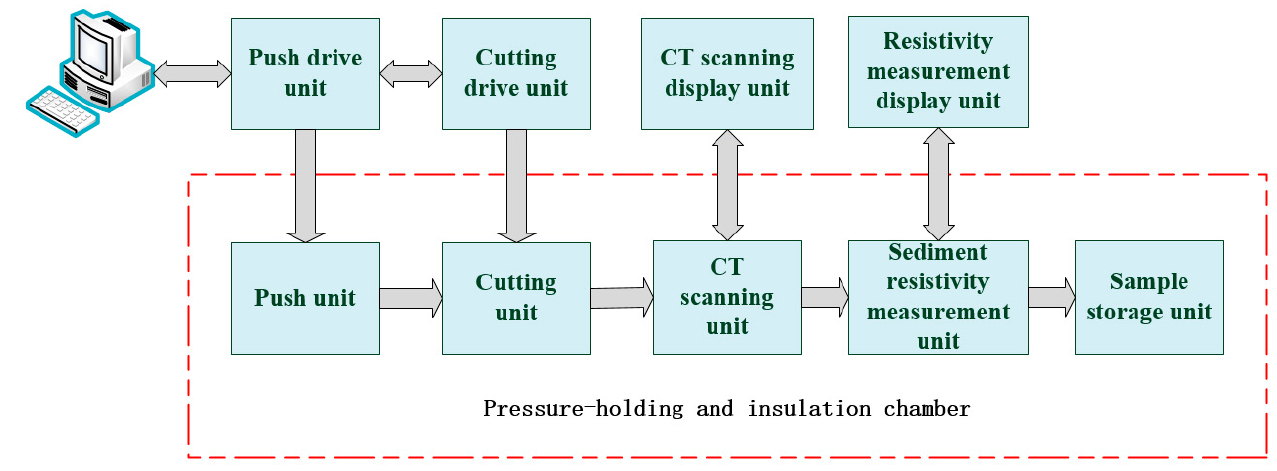
Figure 2. Principle block diagram of the marine sediment resistivity measuring instrument.